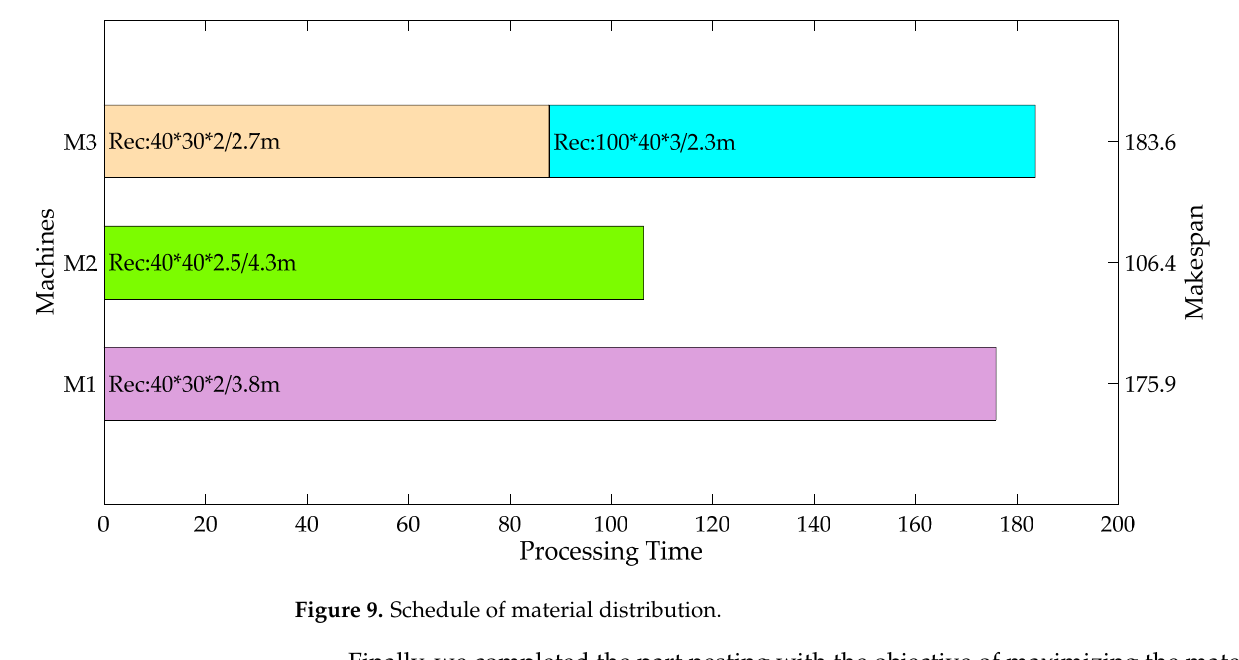
Figure 9. Schedule of material distribution.